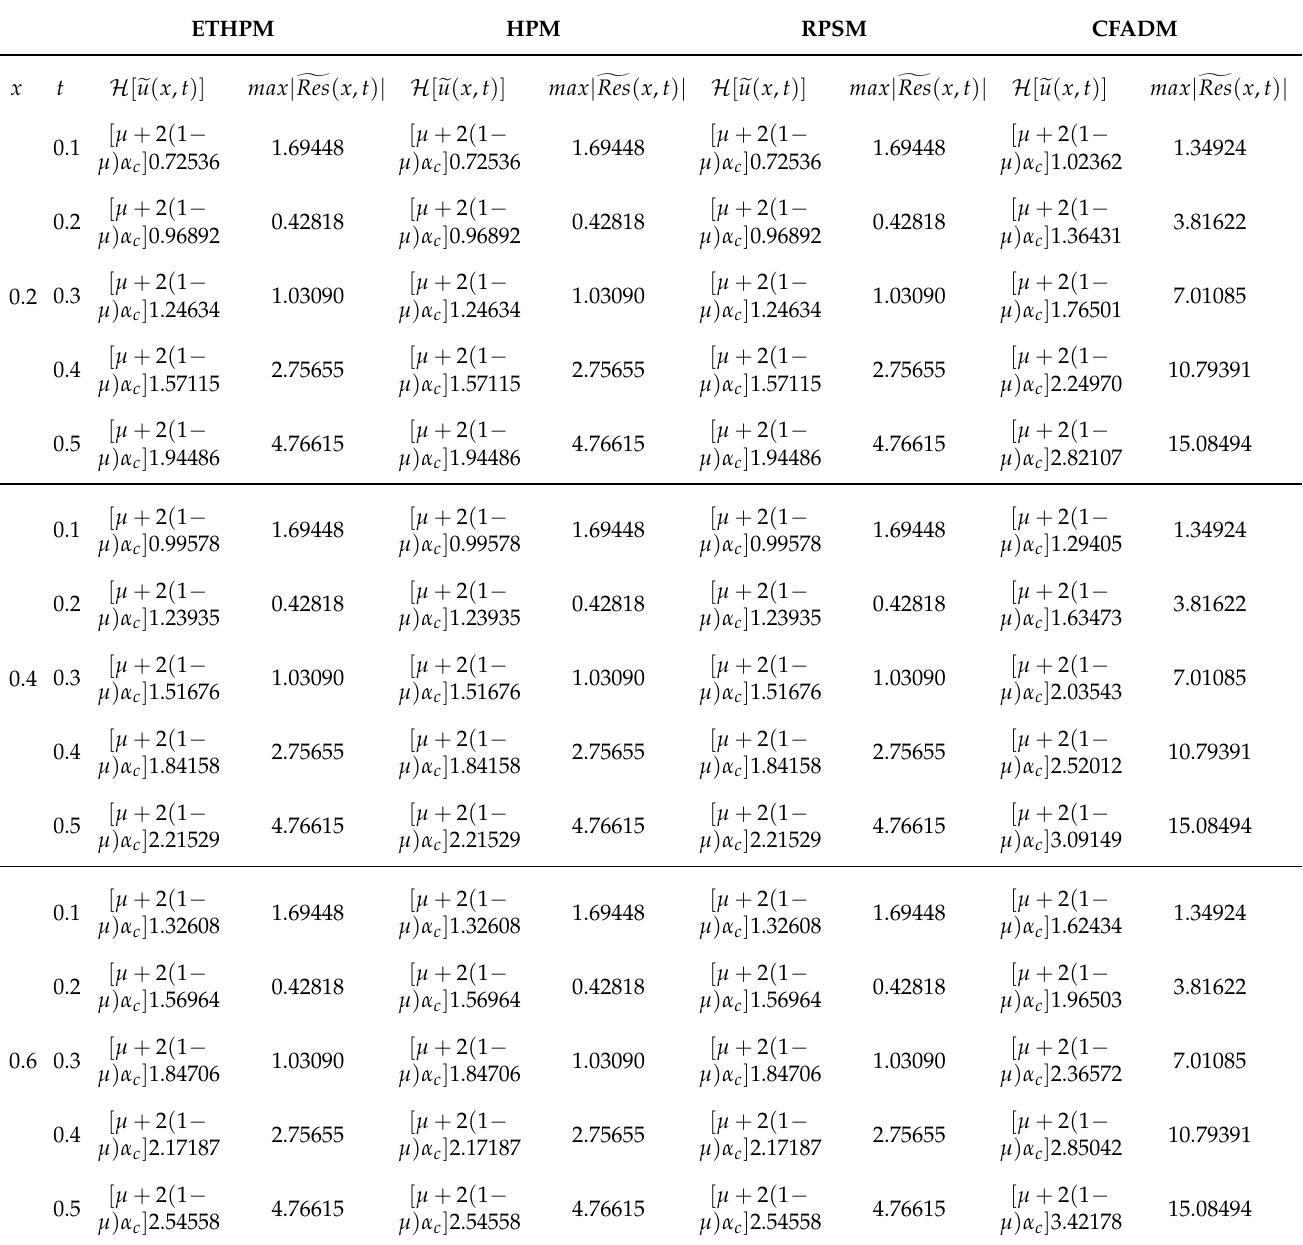
Table 1. H [ (cid:101) u ( x , t )] and max | (cid:103) Res ( x , t ) | by ETHPM, HPM, RPSM, CFADM for α = 0.5, k =